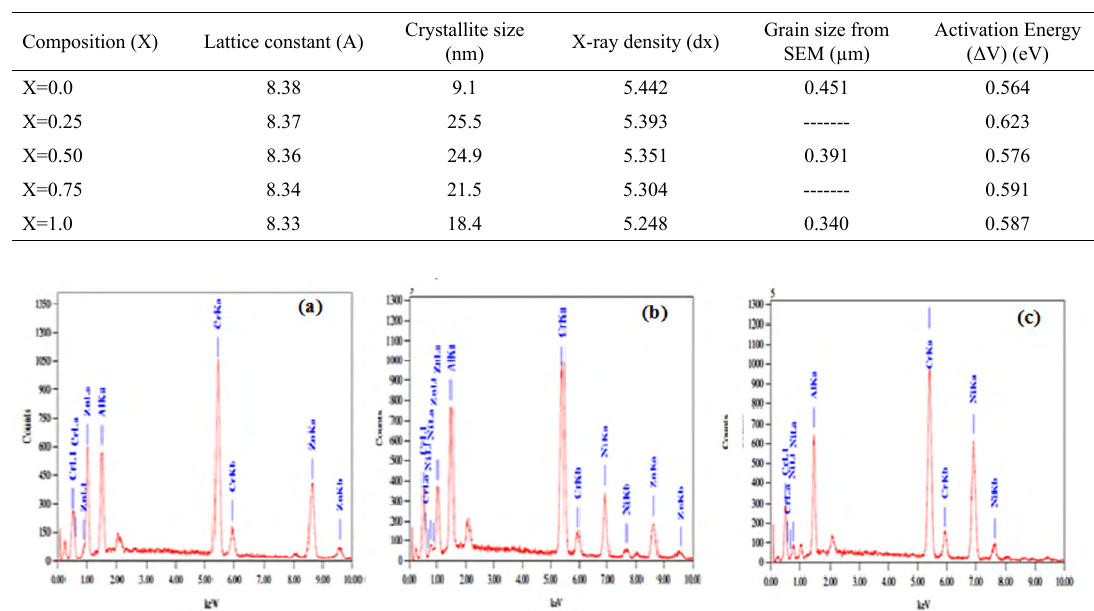
Figure 3. (a-c) EDS pattern for the sample Zn